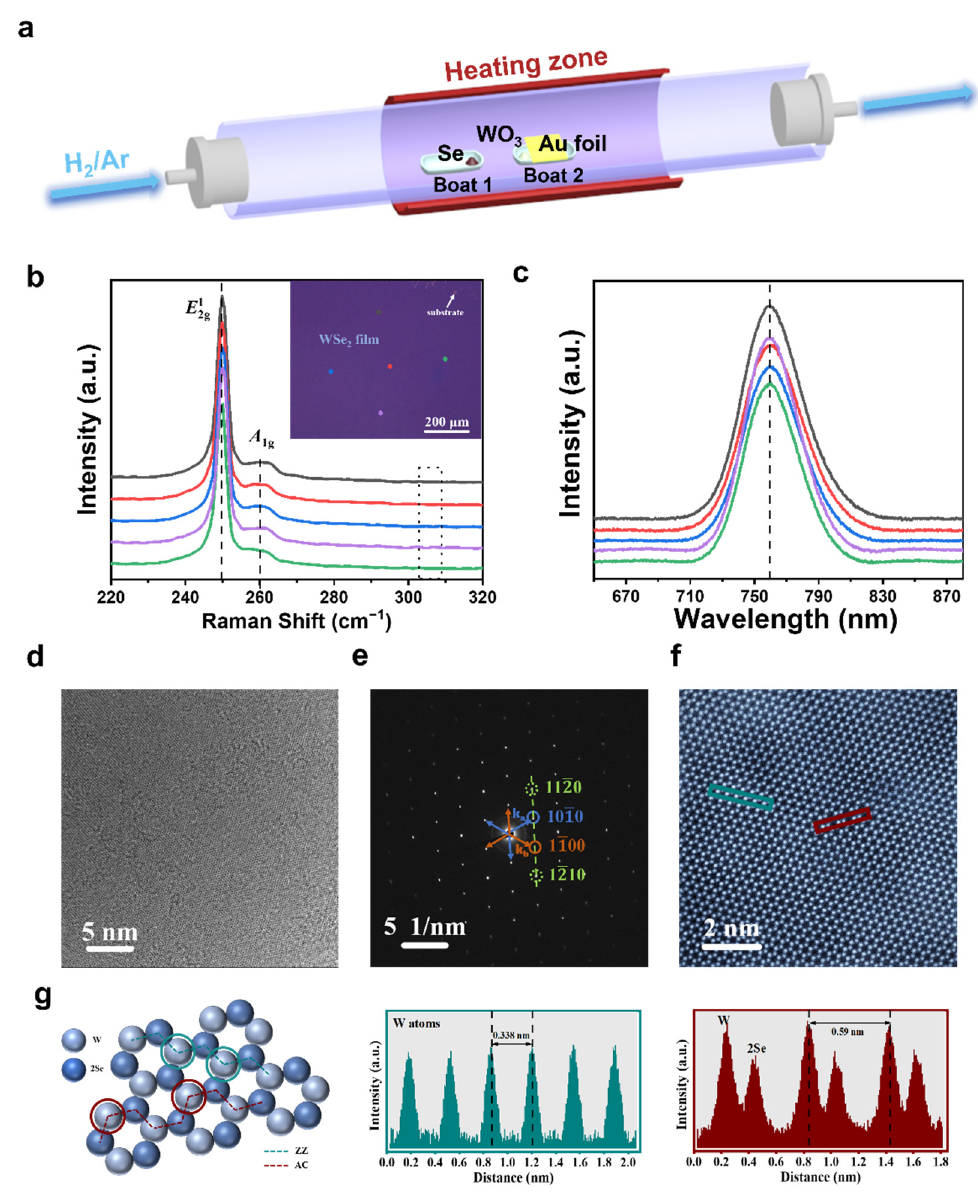
Figure 1. ( a ) Schematics of the CVD setup for the growth of monolayer WSe 2 fi lm on the polycrys- talline Au foil. Raman spectra ( b ) and PL spectra ( c ) were collected from fi ve random points of the WSe 2 sample marked in the insert pictures. ( d ) Low-magni fi cation TEM image of the WSe 2 fi lm. ( e ) Typical SAED pa tt ern of the sample in ( d ). ( f ) The colored STEM image of monolayer WSe 2 fi lm. ( g ) Atomic structure mode of monolayer WSe 2 fi lm. Corresponding intensity pro fi les along the zigzag direction (green) and the armchair direction (red) are labelled in ( f ), respectively.